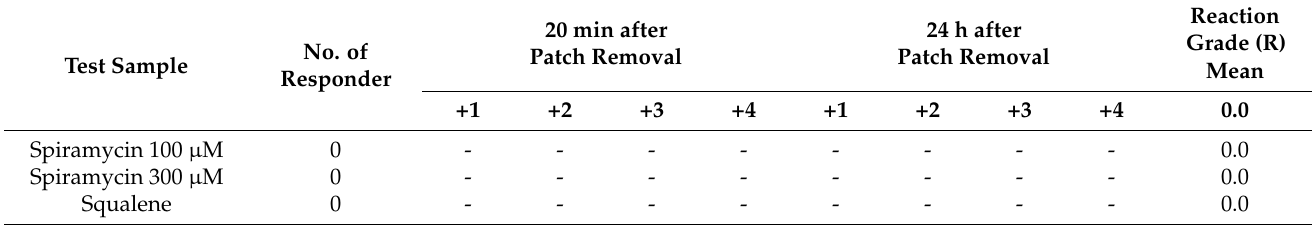
Table 1. The evaluation of spiramycin for primary skin irritation potential in